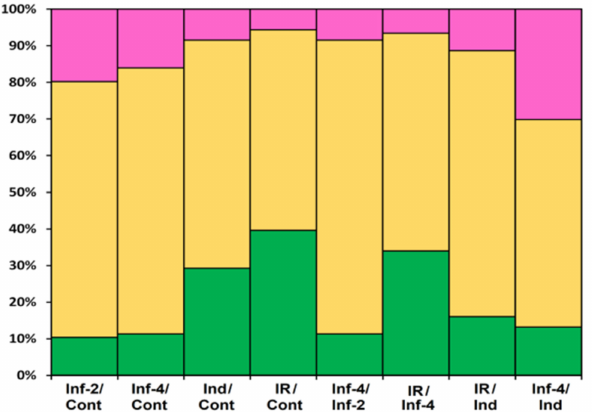
Figure 20. Differentially expressed CRP genes in S. lycopersicum transcriptomes (as a percentage of the total number of expressed CRP genes). Up-regulated genes (expression fold change ≥ 2) are colored green; down-regulated genes (expression fold change ≤ 0.5) are colored pink; genes whose expression level did not change are shown in yellow. The designations below the figure are as follows: Inf/Cont, infected at 2 and 4 dpi versus control; Inf-4/Inf-2, infected at 4 dpi versus infected at 2 dpi; Ind/Cont, elicitor-treated versus control; IR/Cont, IR-expressing versus control; IR/Ind, IR-expressing versus elicitor-treated; IR/Inf-4, IR-expressing versus infected at 4 dpi; Inf-4/Ind, infected at 4 dpi versus